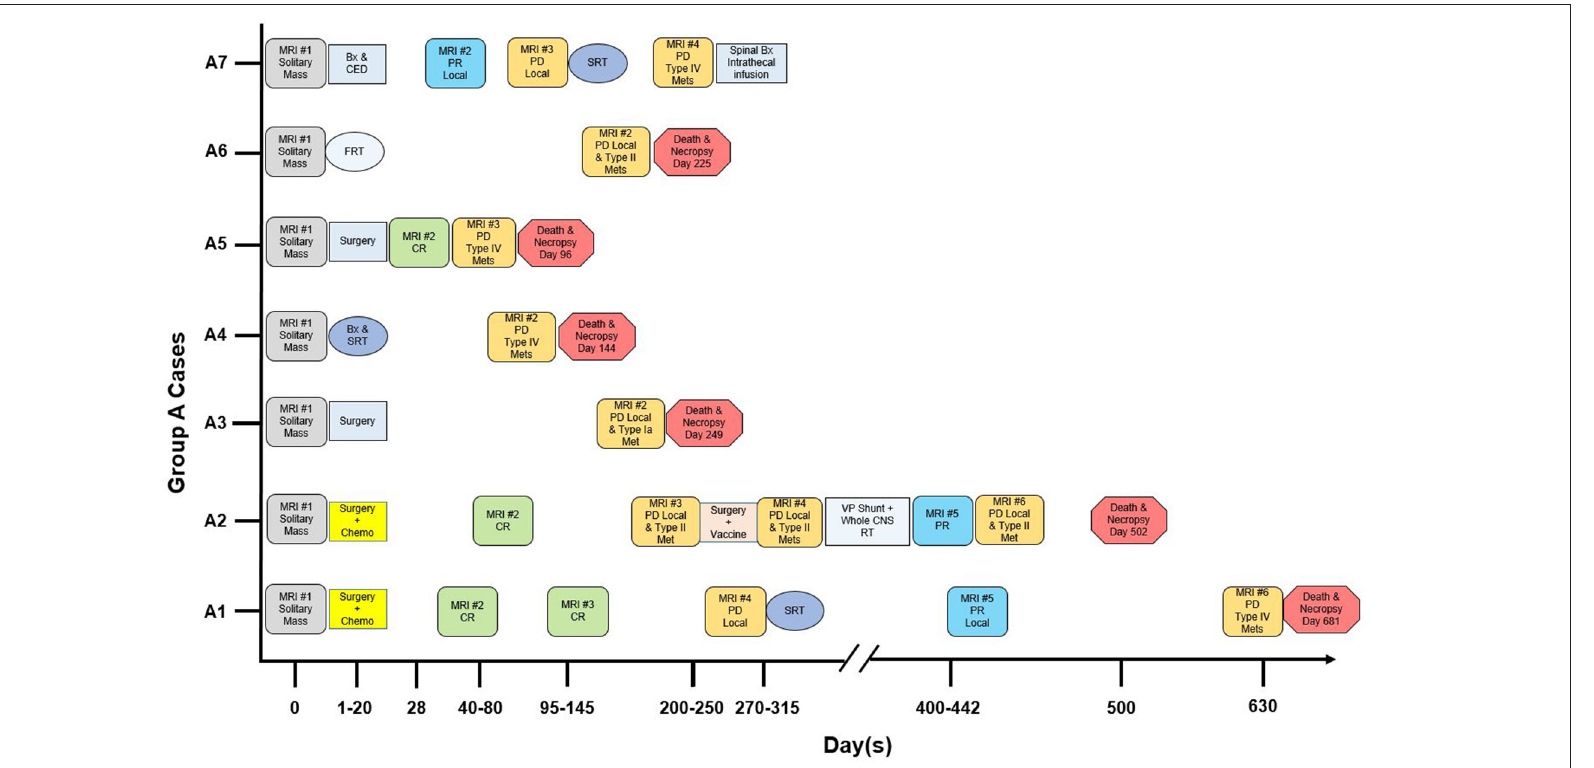
FIGURE 1 | Magnetic resonance imaging (MRI), therapy and outcome in “Group A” dogs with CSF drop metastasis of glioma. Treatment response was designated as complete remission (CR), partial remission (PR), or progressive disease (PD) (9, 10). Bx, stereotactic biopsy. CED, convection-enhanced delivery of QUAD-doxorubicin (11). Chemo, CCNU and chlorambucil chemotherapy (12). FRT, fractionated radiation therapy (50Gy total, 20 fractions). Intrathecal infusion, intrathecal infusion of QUAD-doxorubicin. Met, metastasis. SRT, stereotactic radiation therapy (15-24Gy total, 1–3 fractions). VP, ventriculoperitoneal. Whole CNS RT, whole central nervous system radiation therapy (30Gy total, 10